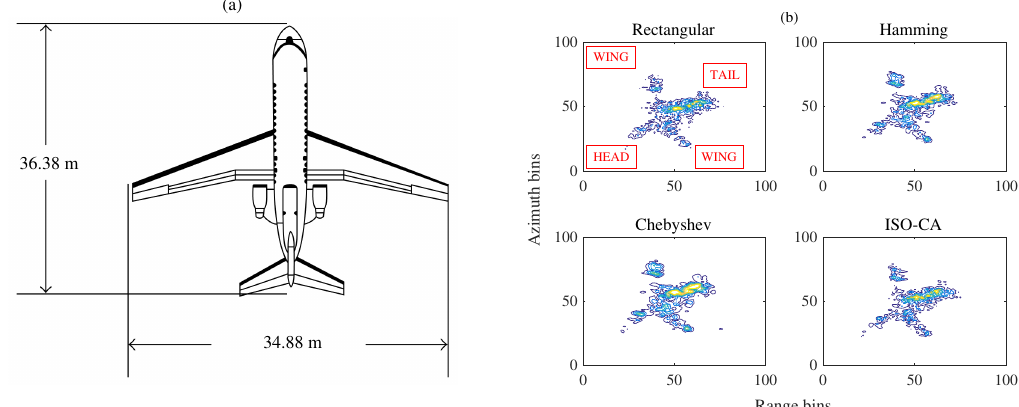
Figure 5. ( a ) Graph of Yak-42; ( b ) ISAR images obtained using different windows (contour